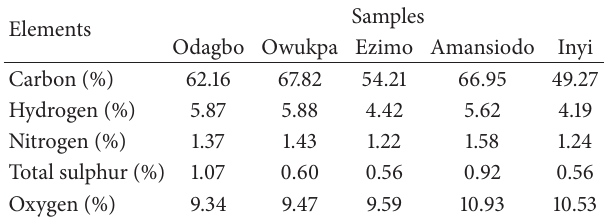
Table 2: Results of ultimate analyses of the five coal